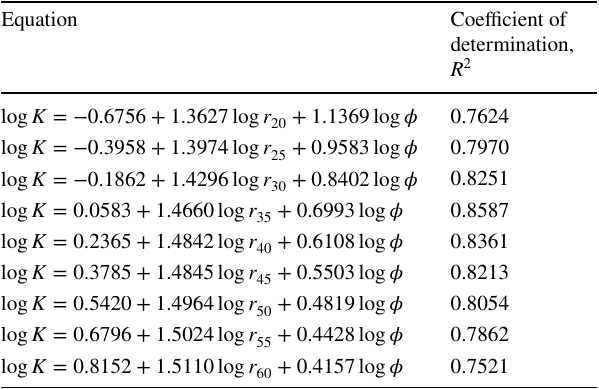
Table 1 Results of regression analysis to establish a relationship between permeability, porosity and the smallest, mercury-filled pore/ throat radiuses Equation Coefficient of